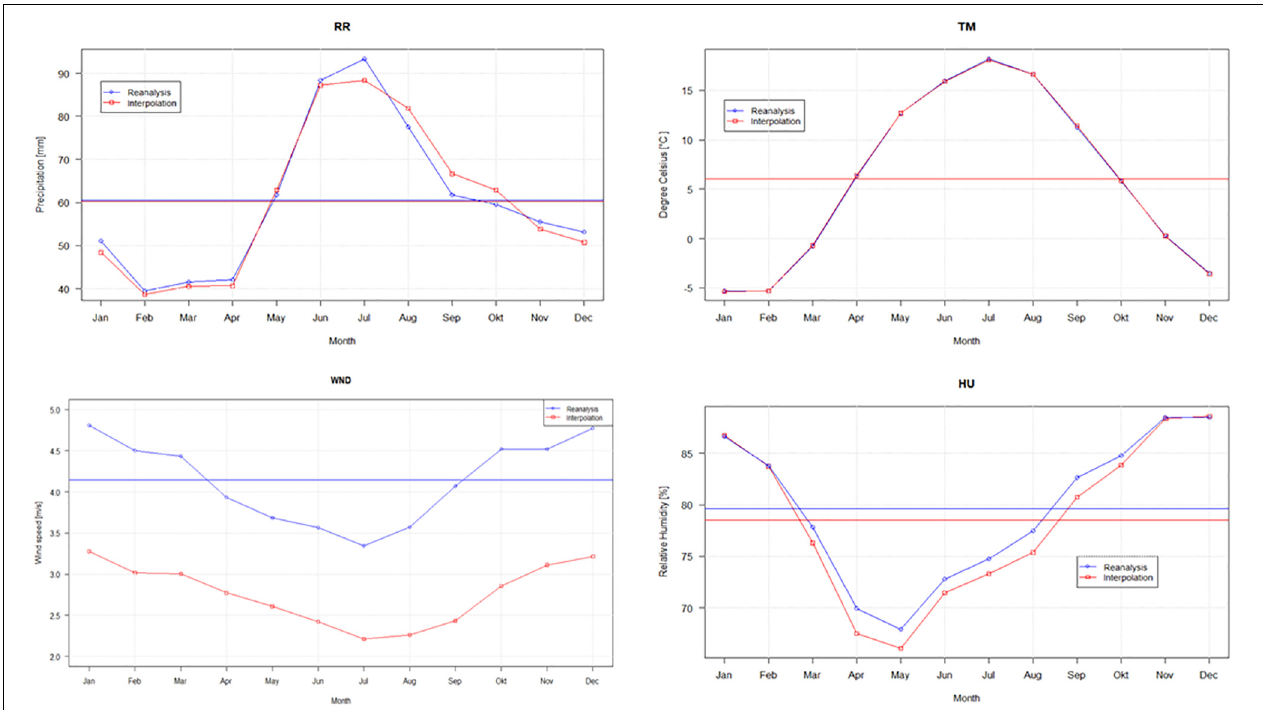
FIGURE 4 | Seasonal cycles of interpolated stations and reanalysis ECMWF ERA-Interim data for precipitation (RR), mean temperature (TM), wind speed (WND), and relative humidity (HU).